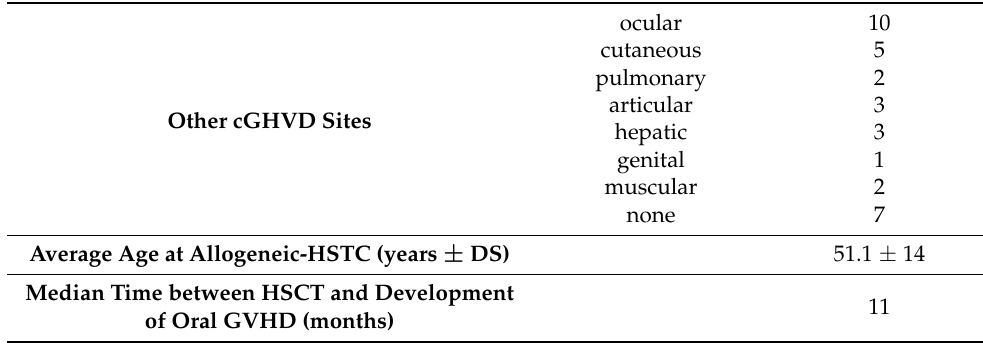
Table legends: cGVHD: chronic graft-versus-host disease; CCL: chronic lymphocytic leukemia; ALL: acute lym- phoblastic leukemia; AML: acute myeloid leukemia; CML: chronic myeloid leukemia; MFI: idiopathic